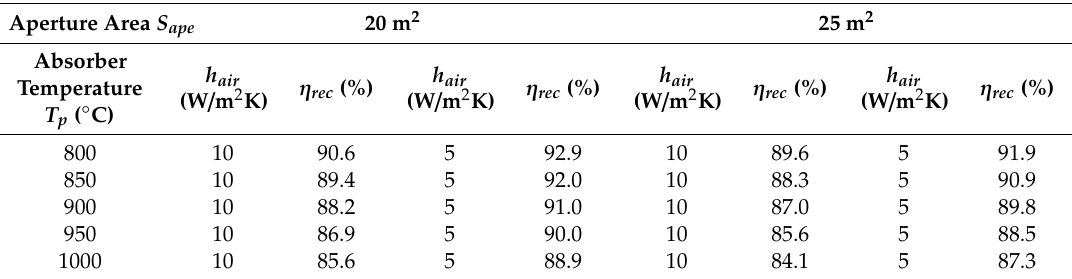
Table 2. Calculations of the receiver e ffi ciency with variations of the absorber temperature, for two aperture areas S ape and two convective coe ffi cients h air , with the following parameters: θ = 2 π / 3 radians, α = 30 ◦ , and d = 9 ape